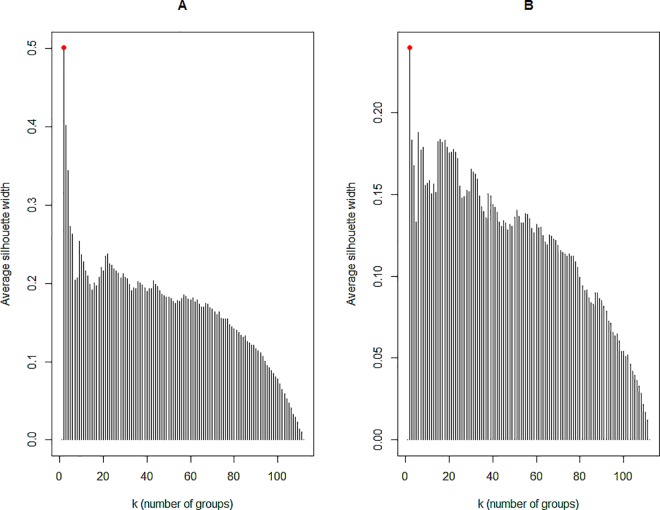
Bar plots showing the average silhouette widths for physicochemical data (A) and melissopalynological data (B). The best partition by this method is the one with the largest average silhouette width. For further details refer to [27].